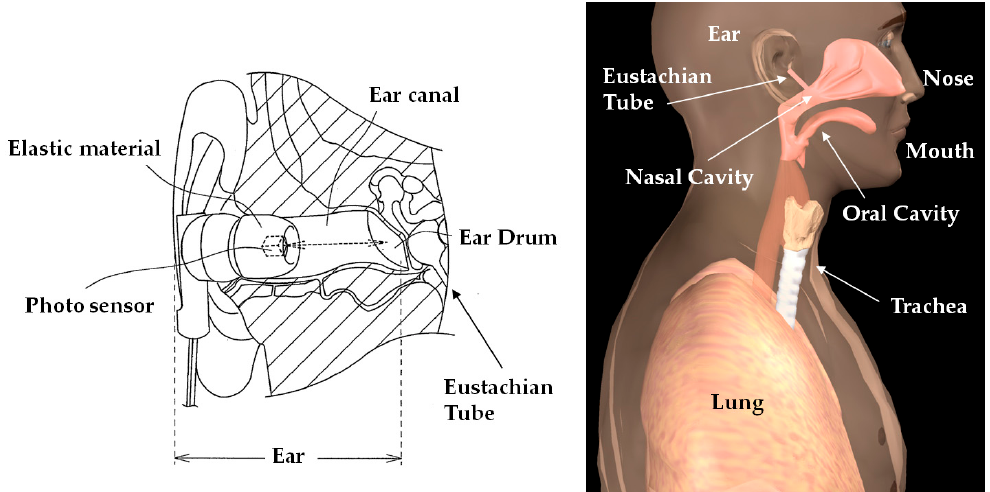
Figure 3. Measurement principles of the ear sensor. The ear sensor has a compact photo sensor attached. The photo sensor irradiates infrared light using an LED to the epidermis of the ear canal, and by receiving the reflected light with a phototransistor, it can measure form changes in the ear canal. The ear canal and a nasal cavity are connected by the eustachian tube. The ear canal and nasal cavity are also connected by the levator veli palatini muscle and tensor veli palatini muscle, which are anatomically close to each other. Based on this, when one breathes, the shape of the ear canal changes. Additionally, as one breathes through the mouth, because the action of opening and closing the mouth results from extension and contraction of the temporalis muscle, this extension and contraction of the temporalis muscle changes the shape of the adjacent ear canal. Usage of the ear sensor enables optical and non-invasive measurement of the aforementioned changes in the shape of the ear canal that occur due to breathing.